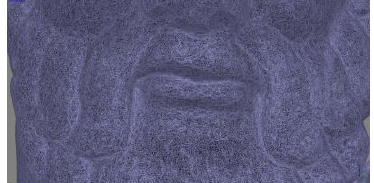
Figure 7. Mesh, depth resolution on mouth details 4 GIGAPIXEL IMAGES